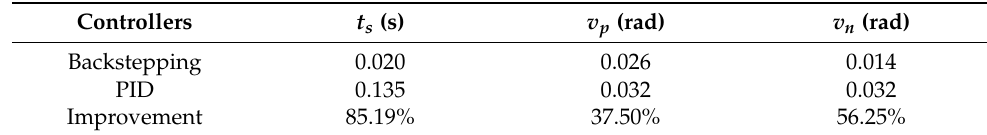
Figure 7. Comparative results with m c = 10 kg and no disturbances. Table 4. Values of the Dynamic Performance Indices.